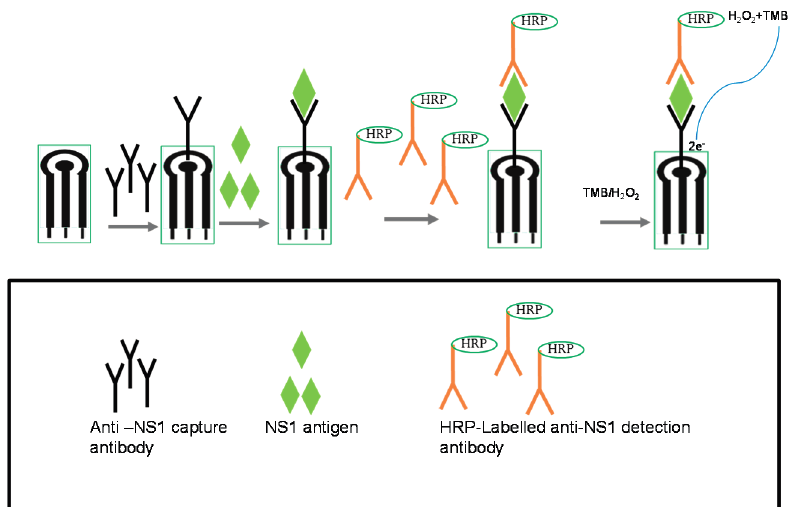
Figure 5. Development of dengue NS1